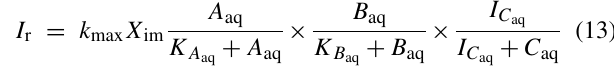
Figure 2. Schematic of a linked list of Reaction Sandboxes com- posed of two reaction objects instantiated from the class hierarchy shown in Fig.